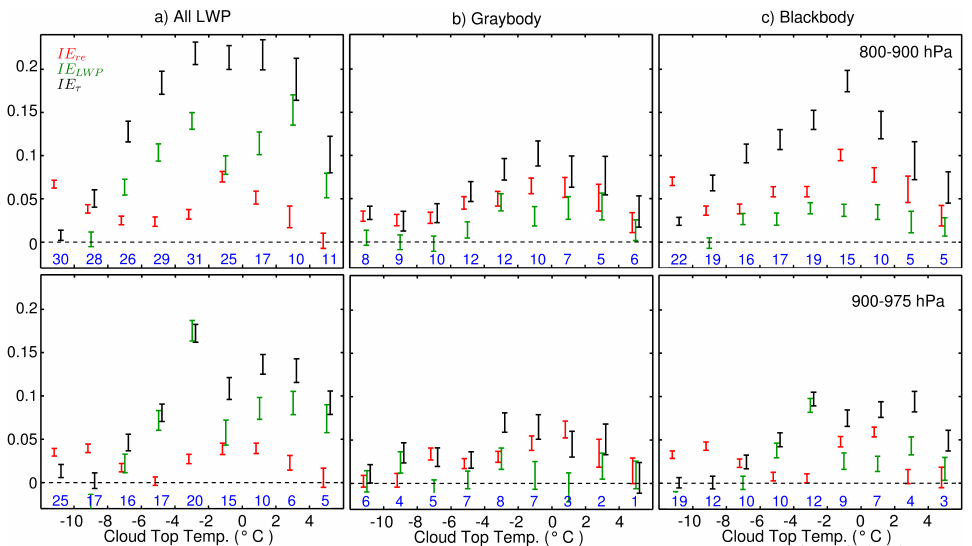
Fig. 6. IE parameter as a function of temperature calculated for liquid clouds ( φ < 50) north of 65 ◦ N from 20 March through 20 July for the layers 800–900hPa (Row 1) and 900–975hPa (Row 2). The bars indicate the 95% confidence limit in the calculation of IE. The figures are grouped according to; (a) all LWP, (b) graybody clouds with LWP < 40gm − 2 or (c) blackbody clouds with LWP > 40gm − 2 . Blue numbers indicate how many FLEXPART grid boxes containing clouds, in thousands, went into the calculation of the IE parameter.